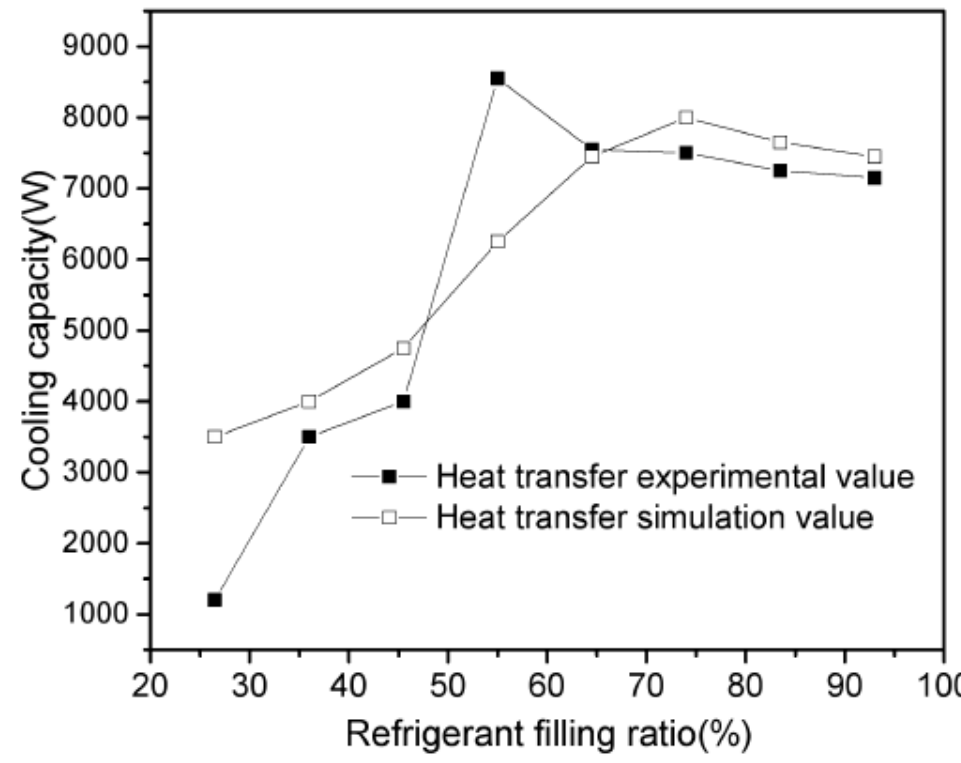
Figure 5. Comparison of experimental and simulated heat transfer values.